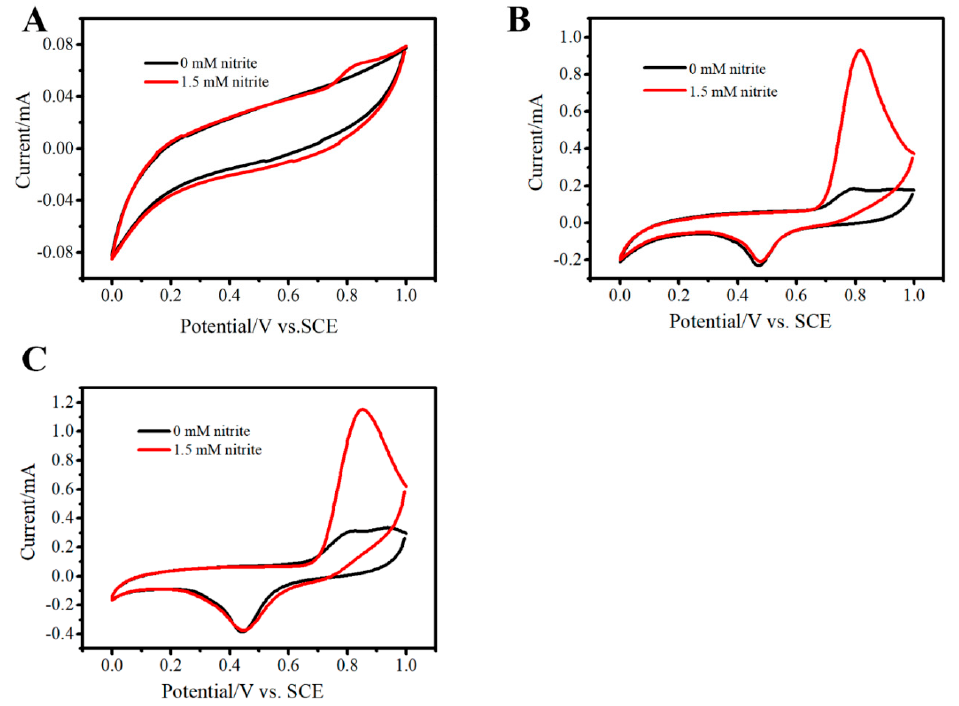
Figure 6. CVs of FTO ( A ), Au/FTO ( B ), 3D Au–rGO/FTO ( C ) in the 0 mM nitrite (black line) and 1.5 mM nitrite (red line) in PBS. Scan rate: 100 mV/s.